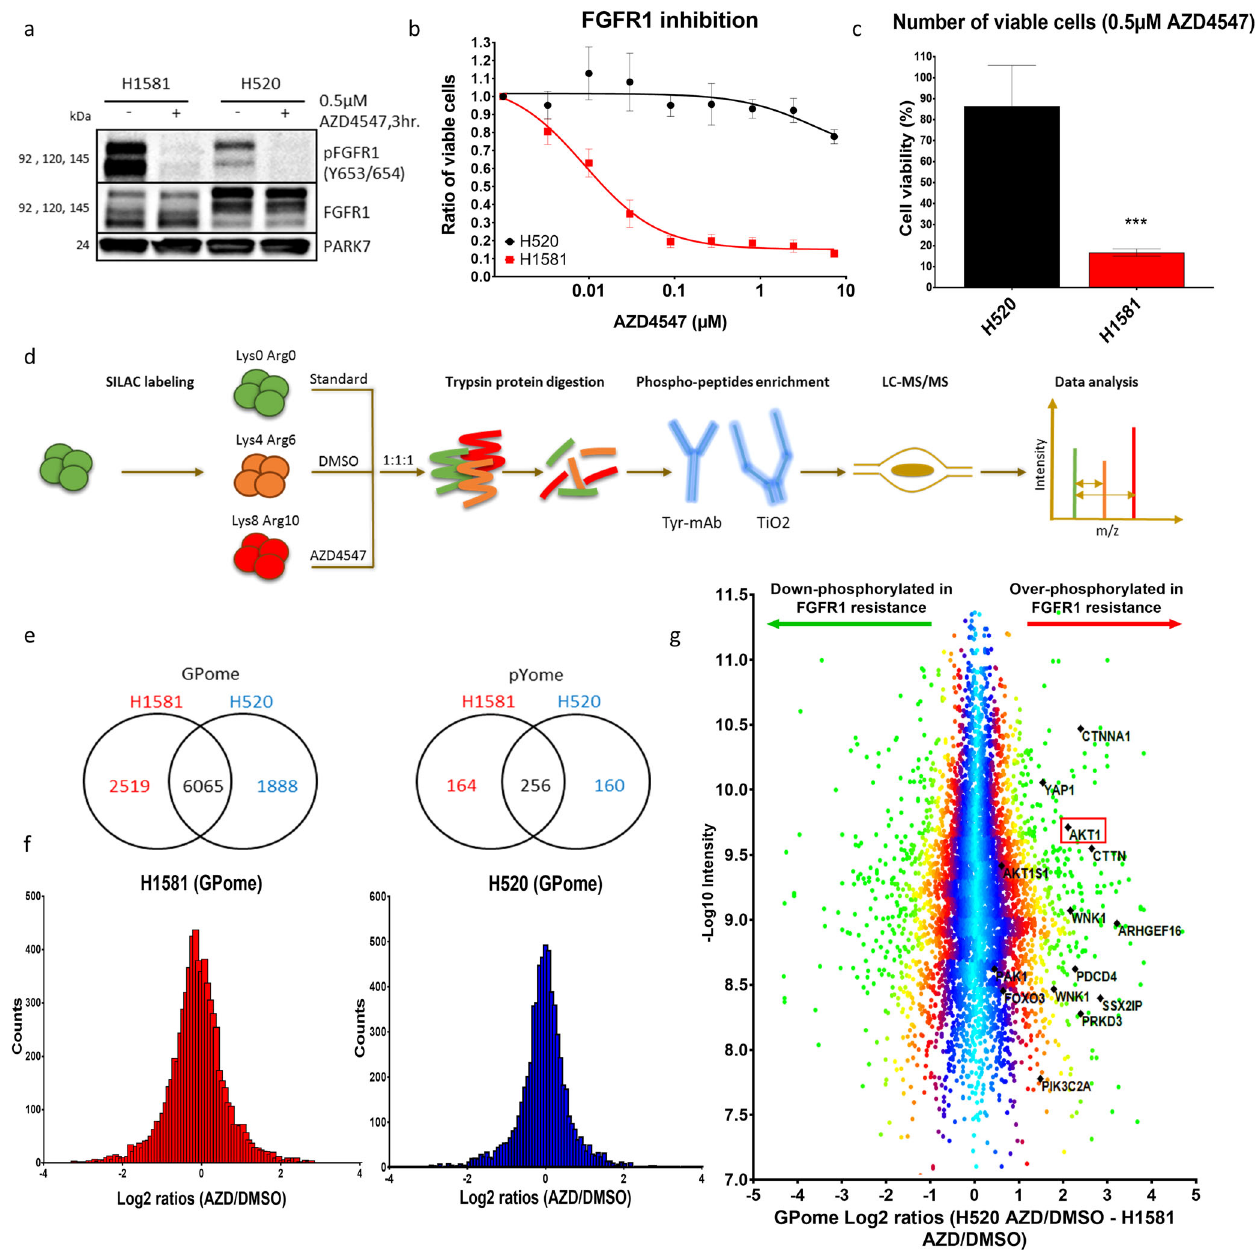
Fig. 1 Differential phosphoproteomic analysis between cells that are sensitive or resistant to FGFR1 inhibition. a Western blot showing expression and phosphorylation of FGFR1 protein under DMSO and AZD4547 treatment. b Cell viability analysis of the two lung-cancer cell lines NCI-H1581 and NCI-H520 after treatment with increasing concentrations of the FGFR1 inhibitor AZD4547 for 96 h. c Viable cells were counted after treatment with 0.5 µM AZD4547 for 96 h and compared with control cells treated with DMSO. d Work fl ow of SILAC labeling, phosphopeptide enrichment and LC-MS/MS analysis. e , f Numeric Venn diagram of phosphosites counted in GPome and pYome and the normal distribution of SILAC ratios between the two cell lines NCI-H1581 ( e ) and NCI-H520 ( f ). g Over- and down-phosphorylated sites in the FGFR1-inhibition-resistant cell line NCI-H520 compared with the sensitive cell line H1581 under AZD4547 treatment controlled against DMSO treatment. Statistical analysis was performed with the chi-squared test: ns ( p > 0.05), *( p < 0.05), **( p ≤ 0.01) and ***( p ≤ 0.001). Mean values are plotted; error bars represent standard